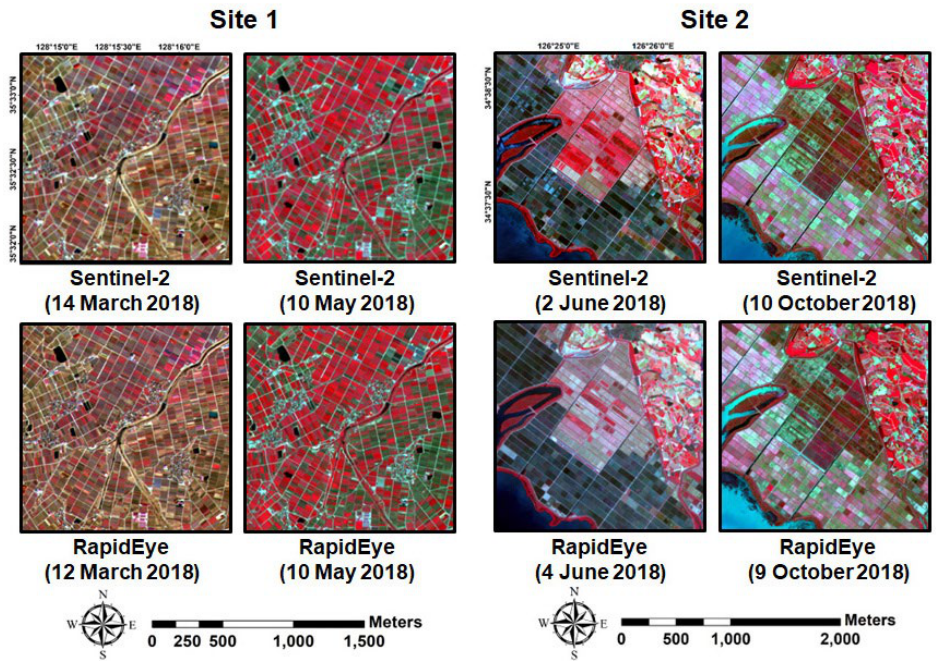
Figure 3. Sentinel-2 and RapidEye color composite images at the two sites (NIR-red-green as RGB).